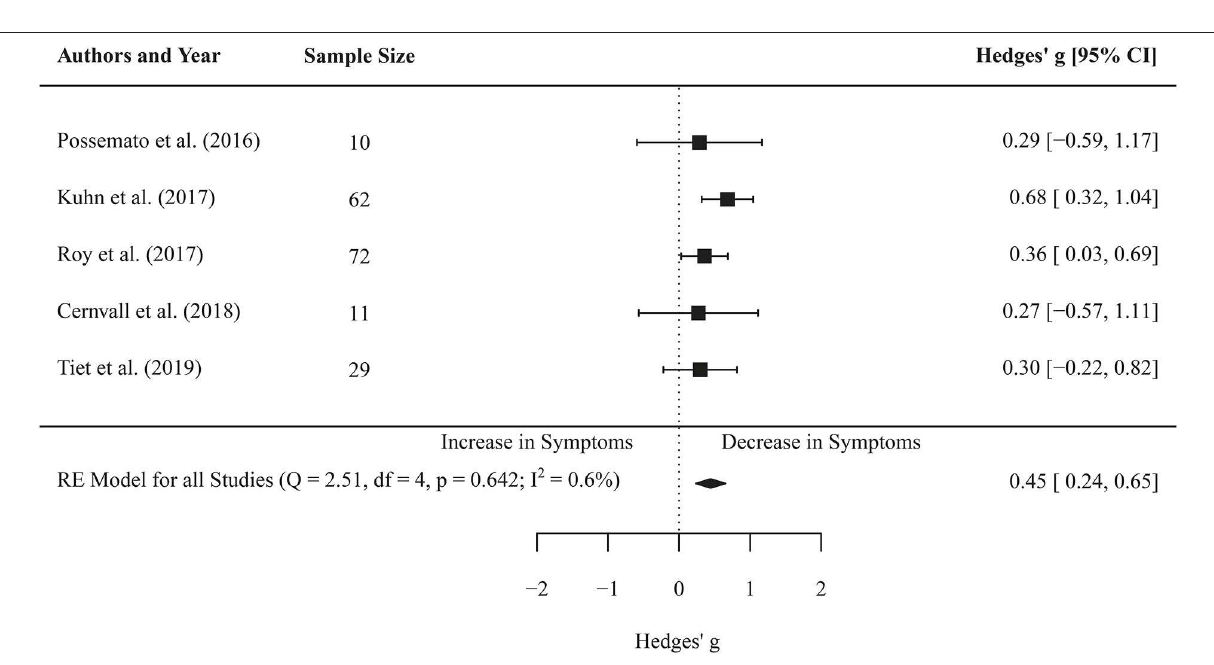
heterogeneity was found between the two studies ( I 2 = 0.00, Q (1) = 0.30, p = 0.584; results not shown). Interestingly, meta- analysis concluded an effect post treatment of g = 0.47 for PTSD